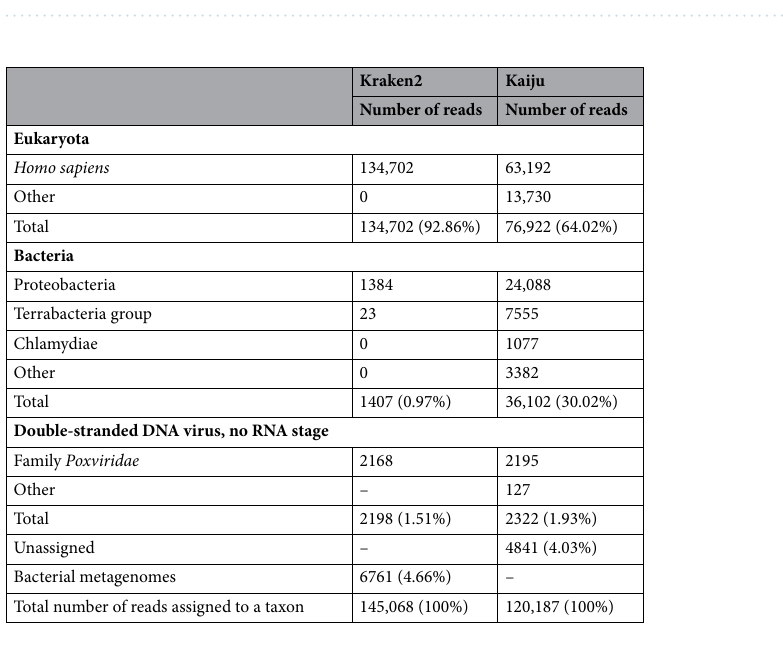
Figure 2. Map of the Central African Republic in Africa. The map was edited in Microsoft PowerPoint (Version 2020).